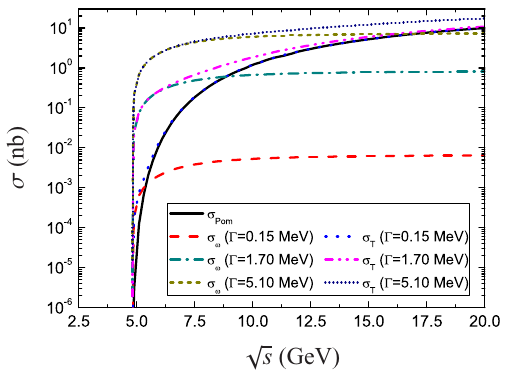
Figure 1. The signal (left panel) and background contributions to γ p → J /ψω p . Here, there are two typical diagrams describing the background contribution, which are marked by (a) and (b).